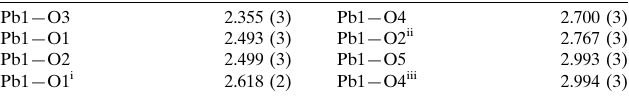
Selected bond lengths (A˚ ).